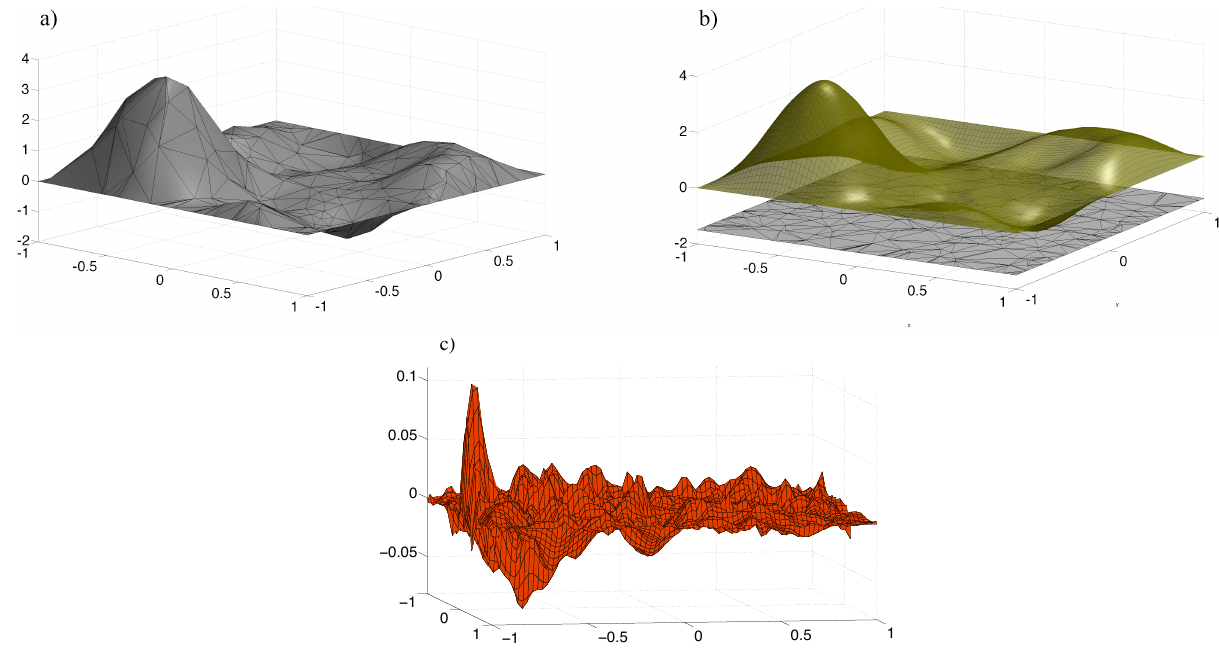
Fig. A1. Example of the interpolation technique used to interpolate the discrete output of the Quoddy model within a fixed sigma level (see A1). (a) Original data obtained by sampling the test function (A9) on a triangular mesh with randomly chosen nodes. (b) Interpolation of the test function (A9) using the nodal values from (a) in (A2); the original mesh is shown in grey, (c) Error residuals of the interpolation (the triangular mesh was randomly generated without trying to adapt the triangle sizes to the function geometry).